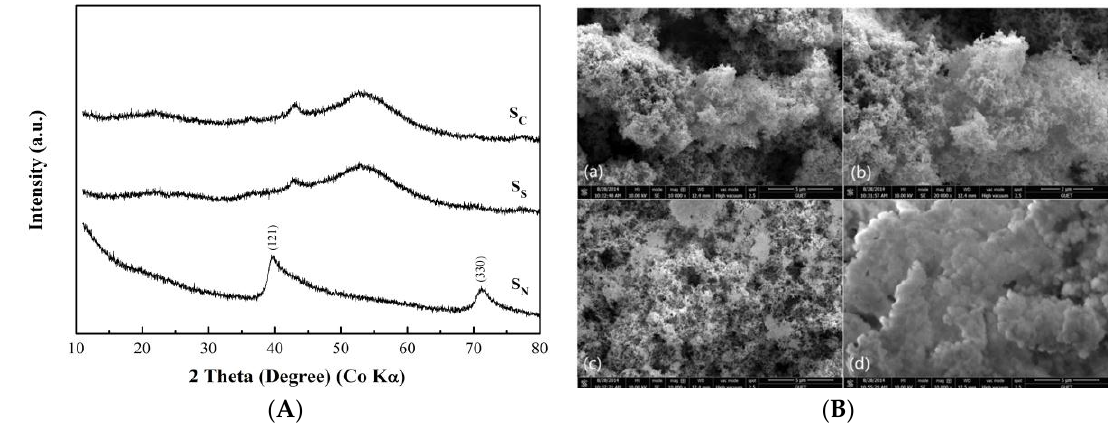
Figure 1. ( A ) XRD patterns and ( B ) SEM micrographs of the as-prepared Co-B alloys: ( a ) and ( b ) for S C at different magnifications; ( c ) for S S ; and ( d ) for S N .